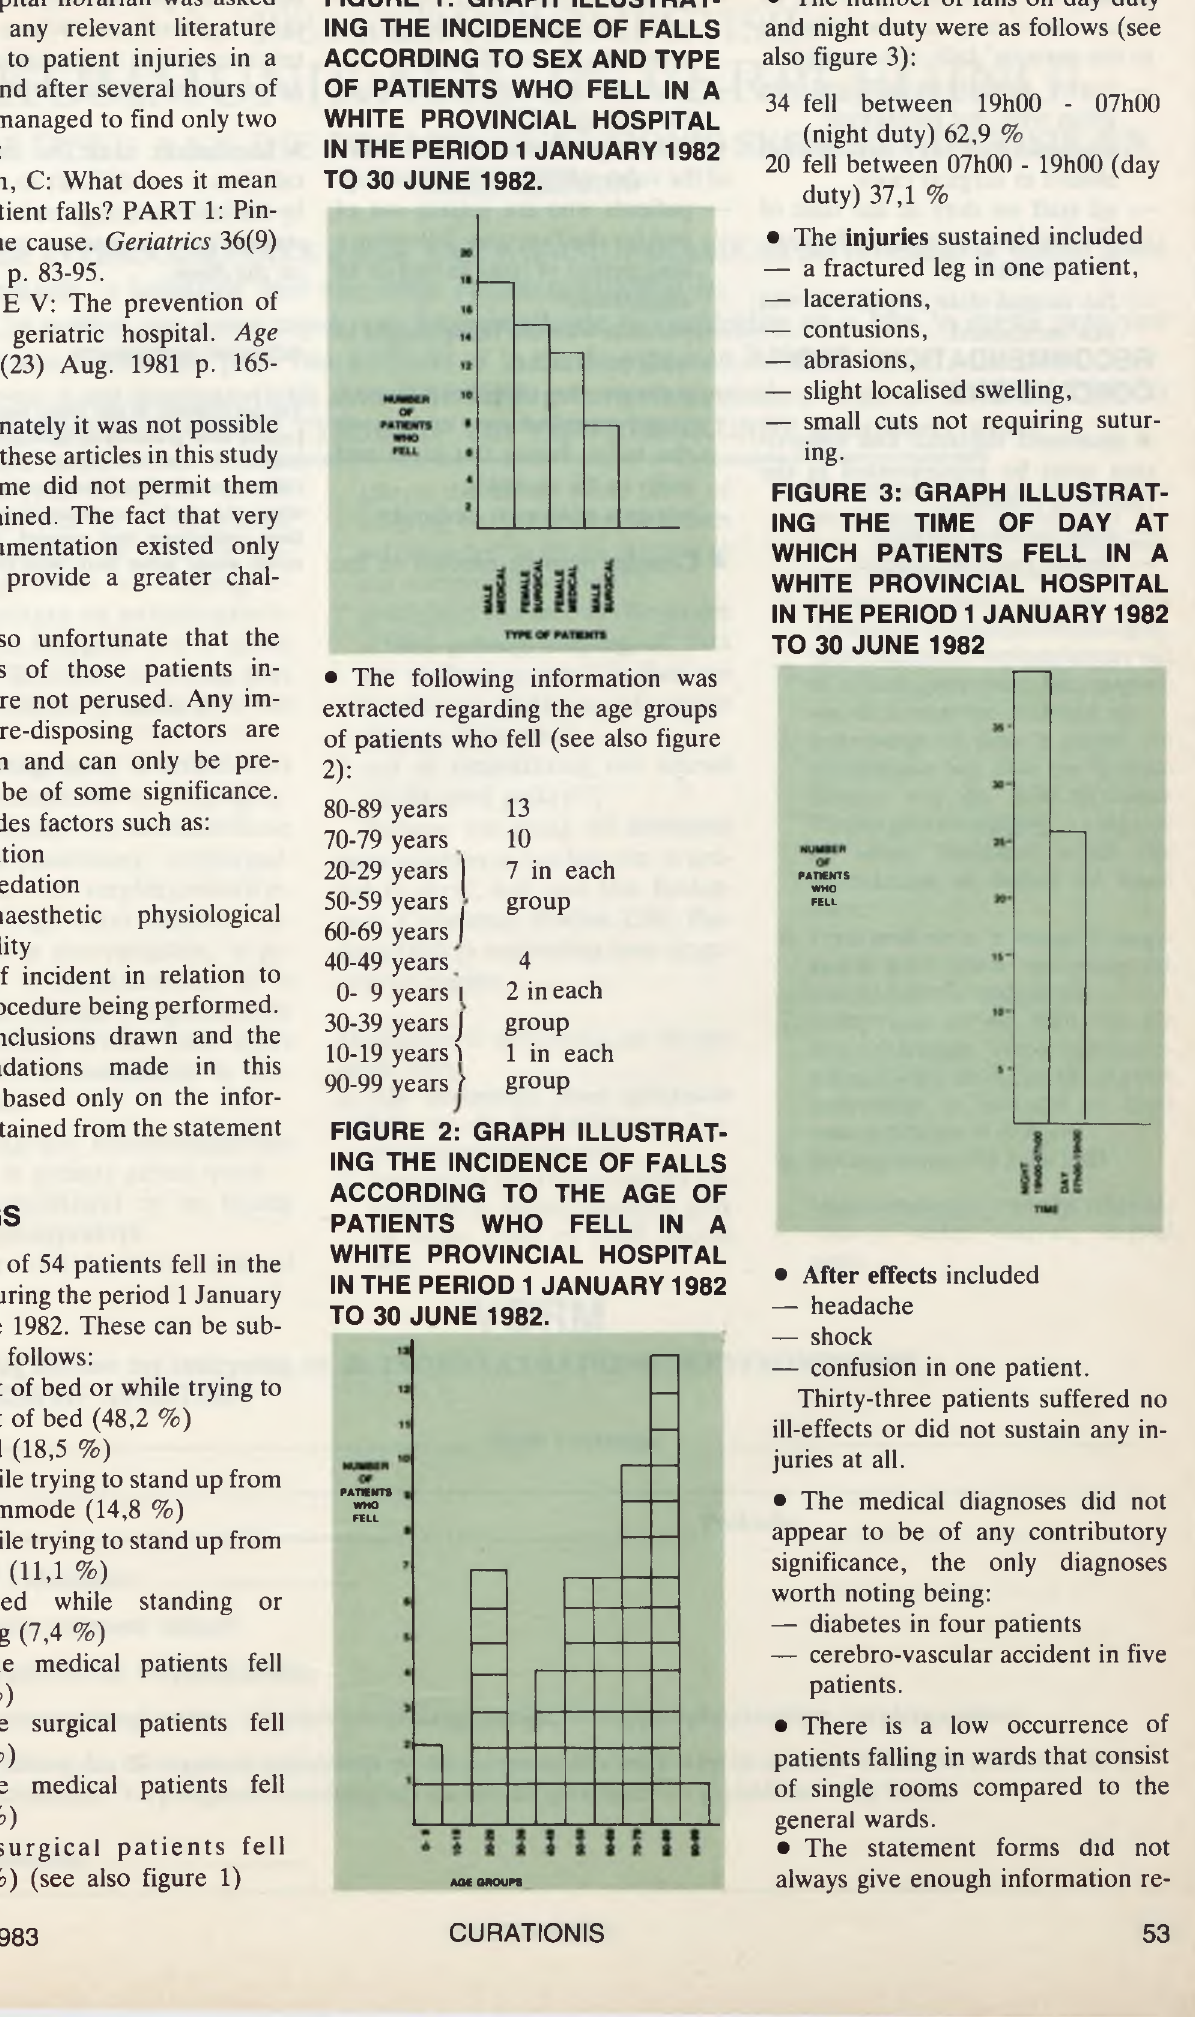
ING THE TIME OF DAY AT WHICH PATIENTS FELL IN A WHITE PROVINCIAL